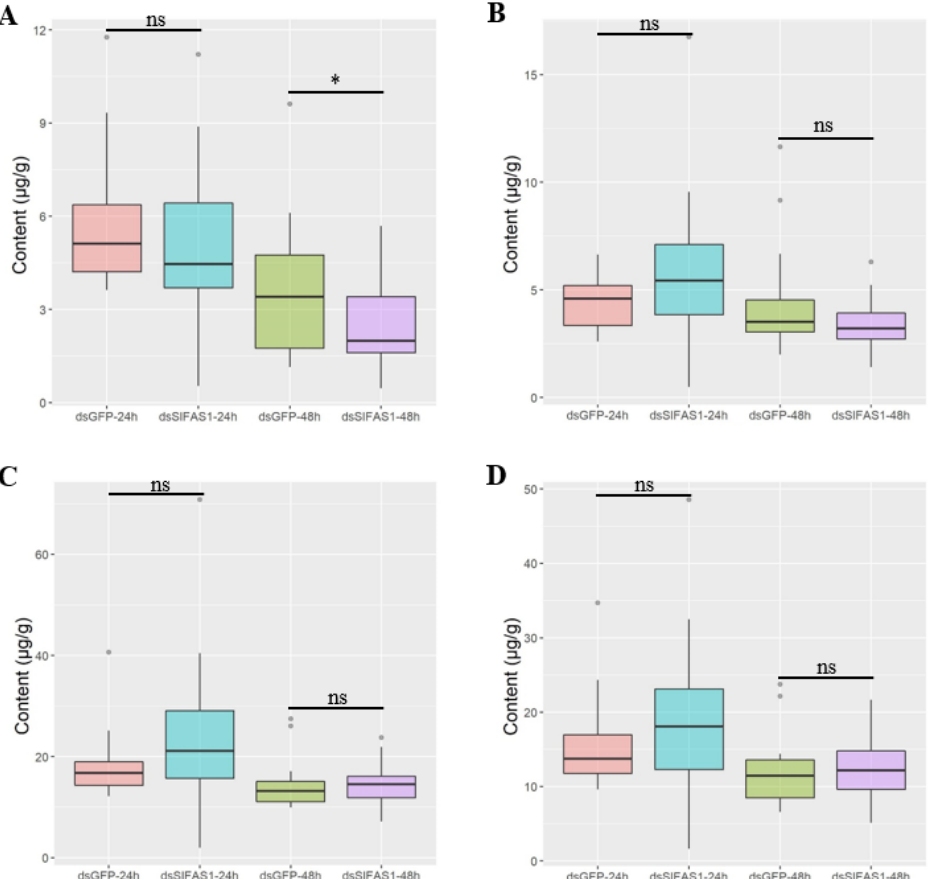
Figure 5. Effect of silencing SlFAS1 on the fatty acid content in S. litura larvae. ( A ) Effect of silencing SlFAS1 on methyl α -linolenate content. ( B ) Effect of silencing SlFAS1 on methyl palmitate content. ( C ) Effect of silencing SlFAS1 on methyl oleate content. ( D ) Effect of silencing SlFAS1 on methyl linoleate content. Significant differences are indicated by asterisks (* p < 0.01; ns: no significant differences; non parametric Mann–Whitney test).